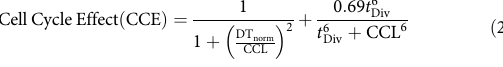
Supplementary Figure 6. After collecting these metrics for every pattern class generated in our training set (7 metrics × 960 networks), the data is mean centered, scaled to unit variance, then transformed using Principal Component Analysis (PCA). The same metrics were extracted from both simulation and experimental data, scaled/normalized in an identical fashion to our training set, and transformed into latent variable space using the previously trained PCA transform. The average trajectories for simulations were calculated by averaging every data point at a speci fi c